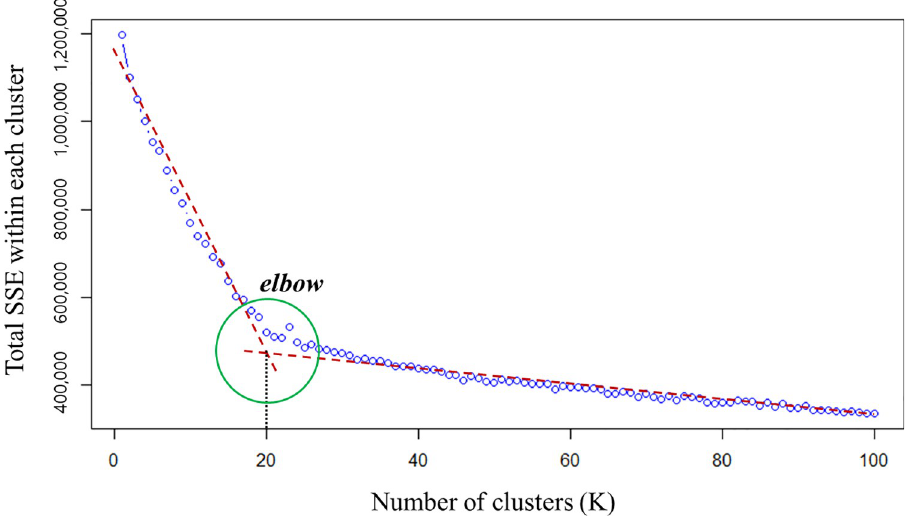
Fig 8. Total SSE within the cluster according to the number of clusters K . Note: In this figure, an elbow is observed when the number of clusters is 20.